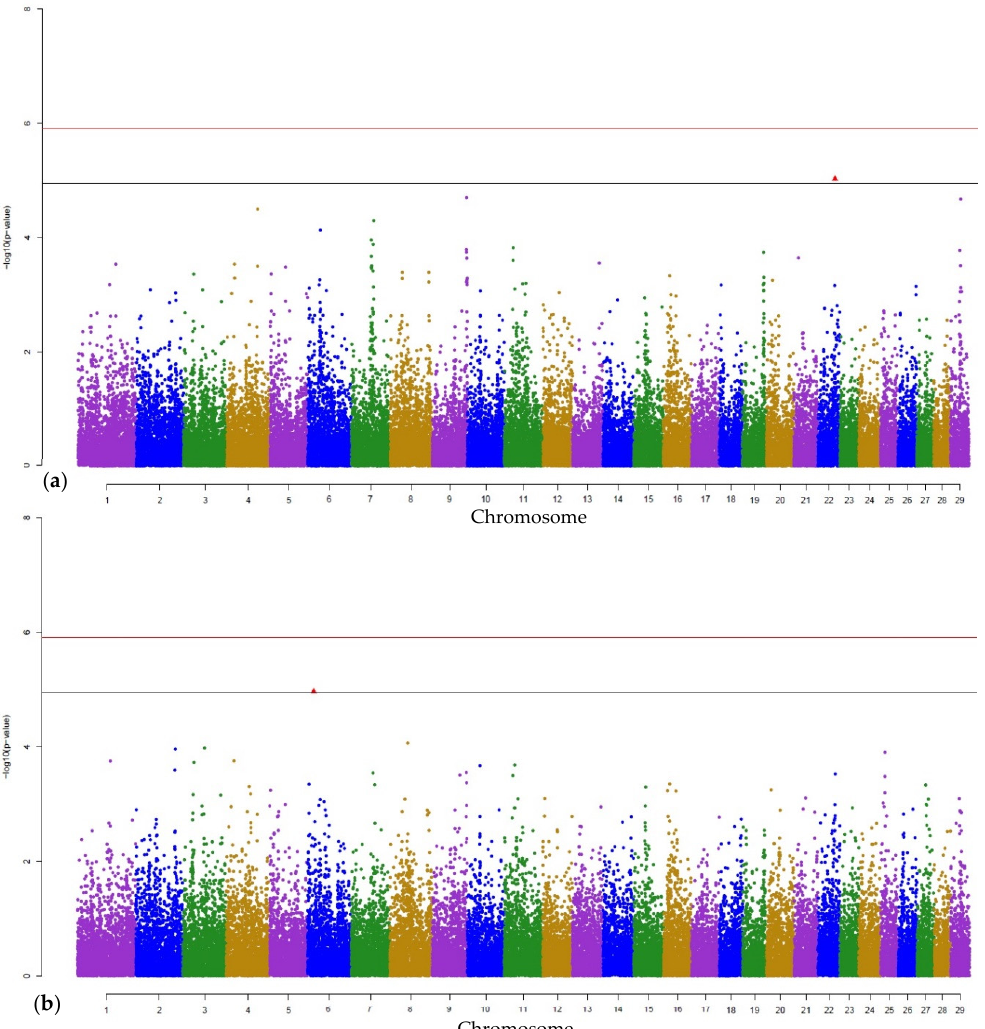
Figure 1. Manhattan plots displaying the GWAS results ( p -values) for polymorphonuclear neutrophils (PMN): ( a ) indicates the main SNP effect, and ( b ) the interaction effect between SNPs and housing system. The Bonferroni-corrected genome-wide significance (red line) and the less conservative threshold (grey line) ( p sugg = 0.05/4479 = 1.12 × 10 − 5 ) are shown. Red triangles highlight the significant SNP.